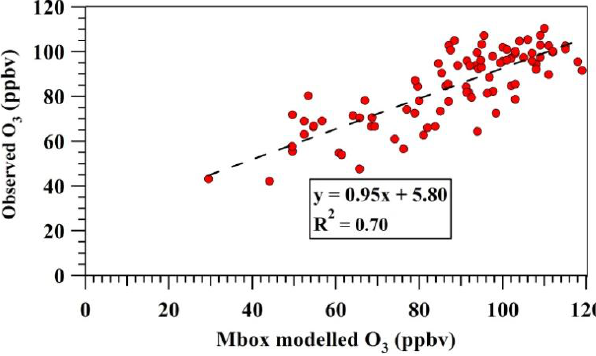
Fig. 7. Scatter plots of (a) CO and (b) SO 2 during daytime and nighttime hours between TMS and TW.